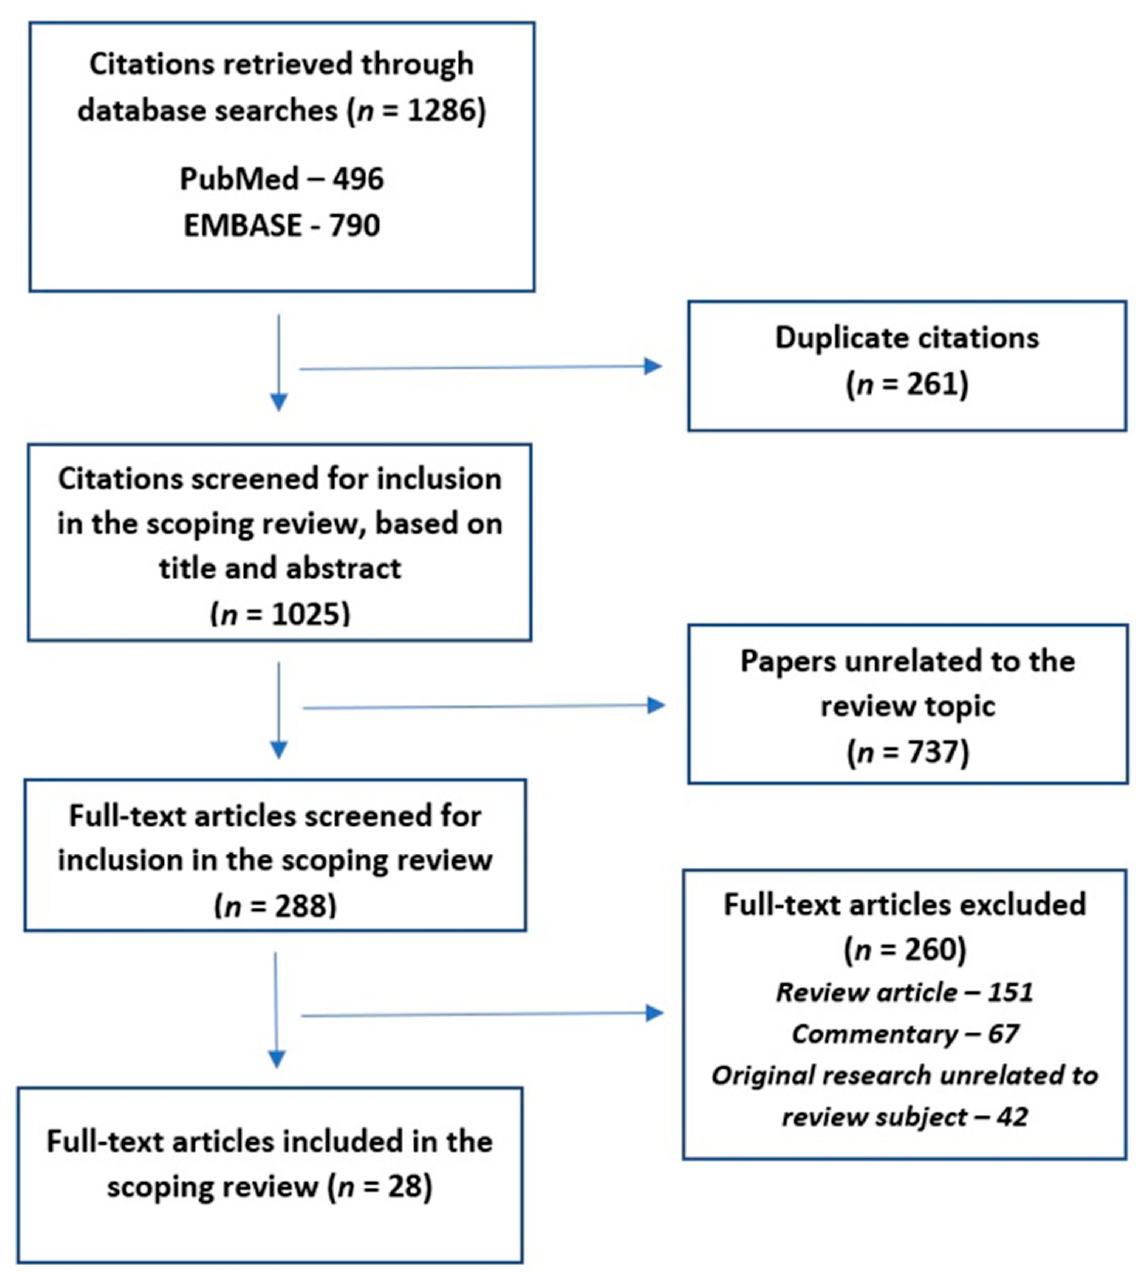
Figure 1. PRISMA-ScR flow diagram for the current review.